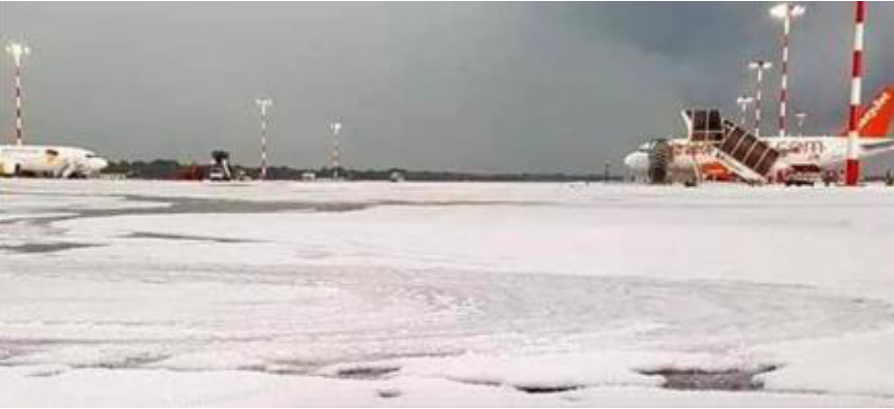
Figure 12. Apron of a runway at MXP on 11 May 2019 [53].